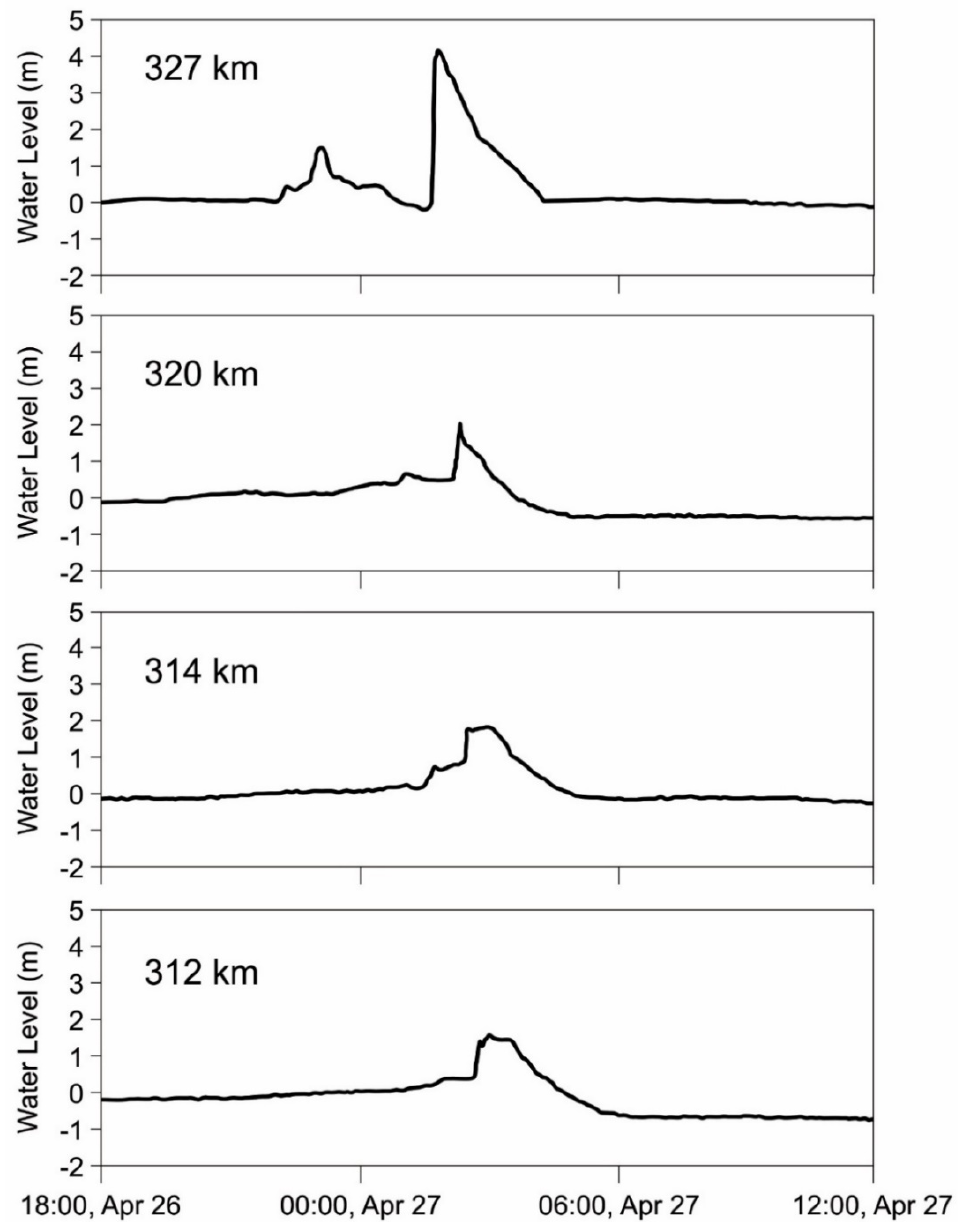
Figure 2. Passage of a 2002 jave in a 15 km reach of the Athabasca River, captured by temporary water level gauges at different locations above Fort McMurray, Alberta, Canada. The km values represent approximate river distances upstream of the Athabasca River mouth; the Grant MacEwan bridge at Fort McMurray s located at km ~295. Adapted from [41], with changes.